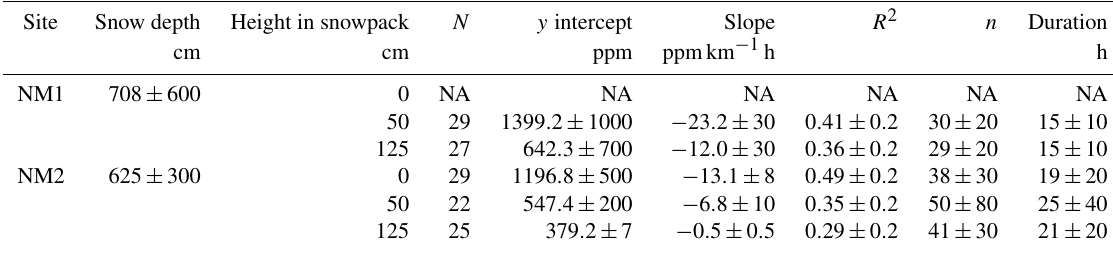
Figure 4. (a) Time series of wind speed and CO 2 concentration at 125cm above the ground from 06:30 on 2 January 2014 to 14:00 on 3 January 2014 at NM1. Average snow depth at NM1 over this time period was 124cm. Therefore, these CO 2 values were a good representation of the snow–air interface. (b) The corresponding linear regression of CO 2 concentration versus average wind speed ( R 2 = 0 . 53, P < 0 . 001). Table 2. Summary of regression analysis between CO 2 concentration within the snowpack and wind speed. Data were filtered to satisfy the following conditions: (1) snow cover was considered to be at equilibrium, (2) the relationship produced a slope <0, and (3) R 2 ≥ 0.1. N is the number of time periods that satisfy all three conditions. Each time period covered a minimum of 6h. The y intercept is the mean CO 2 concentration when wind speed is 0kmh − 1 . Slope is the mean change in CO 2 concentration with a 1kmh − 1 increase in wind speed. R 2 is the mean strength of the relationship between CO 2 concentration in the snowpack and mean wind speed. n is the mean number of half-hourly observations within each N . Duration is the mean duration of N . Instrumentation error for the NM1 0cm CO 2 probe prevented data collection at that height. Instrumentation error for the NM1 0 cm CO2 probe prevented data collection at that height, and so data at that height is not available